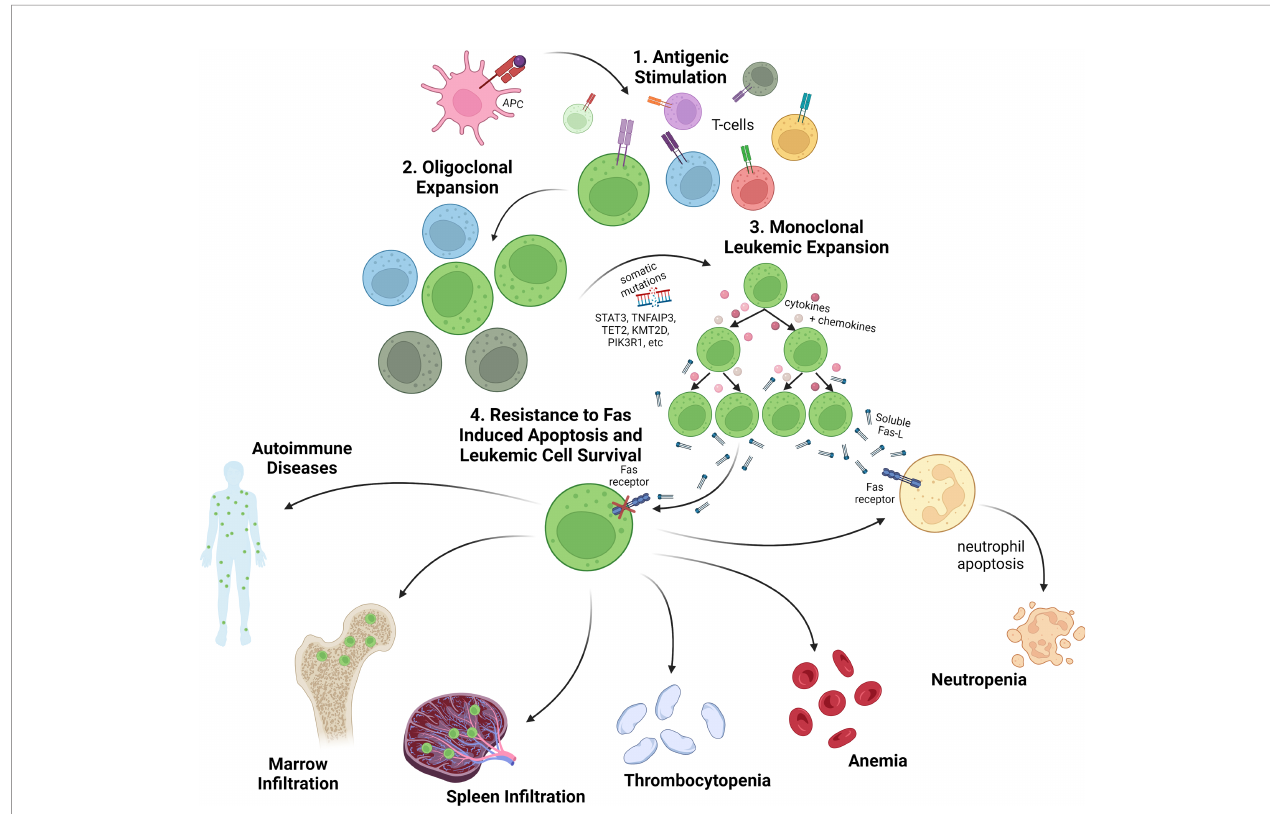
FIGURE 1 | Overview of LGL leukemia pathogenesis and clinical presentation. 1. T-cell LGL leukemia is presumed to arise following antigenic stimulation of normal T-cells. 2. Upon oligoclonal expansion of antigen reactive T-cells, somatic mutations are acquired in genes regulating key T-cell survival pathways as well as epigenetic regulators. 3. The leukemic expansion is characterized by clonal T-cell receptor rearrangements, somatic variants (especially somatic activating mutations in the STAT3 gene), and an activated cytotoxic T-cell phenotype with secretion of in fl ammatory cytokines and chemokines, such as sFasL. 4. Leukemic LGLs are resistant to Fas-induced apoptosis and are characterized by activated cell survival pathways. Cytopenias, especially neutropenia and anemia, are a common disease feature and the main indicators for treatment. Leukemic LGLs also invade spleen, marrow and other organs where they contribute to cytopenias and autoimmune diseases. Created with